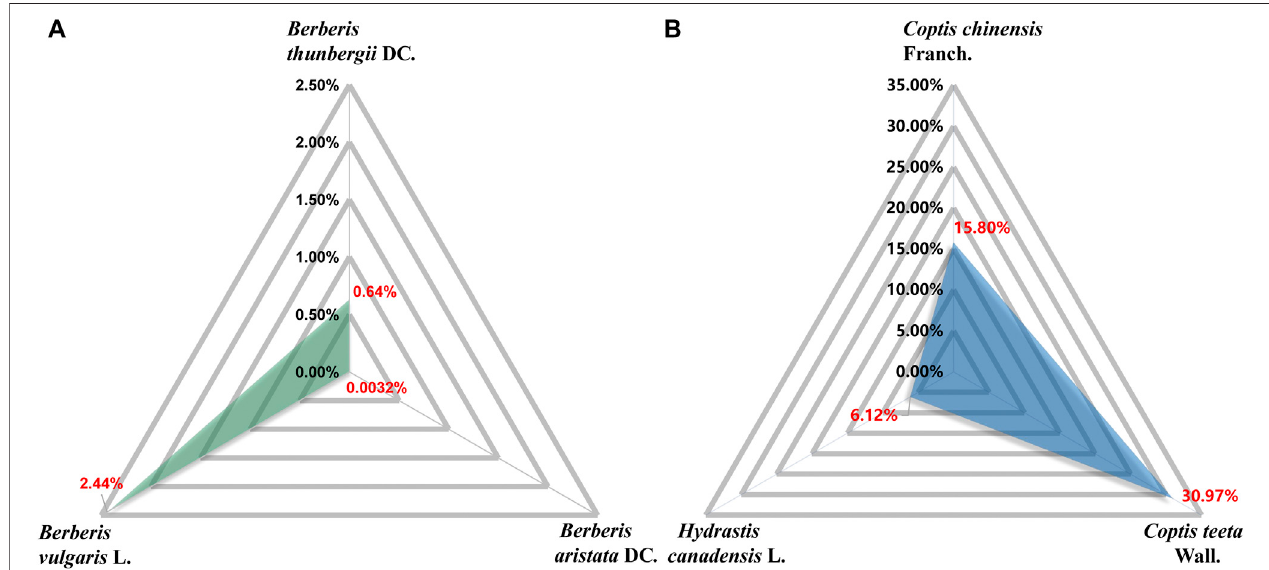
FIGURE 2 | Content of BBR in corresponding plant parts. Berberis vulgaris L. dry root: 2.44% (Ahmad et al., 2019). Berberis thunbergii DC.: 0.64% (Och et al., 2017). Berberisaristata DC.stembark:0.0032%(Khanetal.,2020). Hydrastiscanadensis L.root:6.12%(Ettefaghetal.,2011). Coptischinensis Franch.waterextracts: 15.80% (Roh et al., 2020). Coptis teeta Wall. rhizome: 30.97% (Goswami et al.,